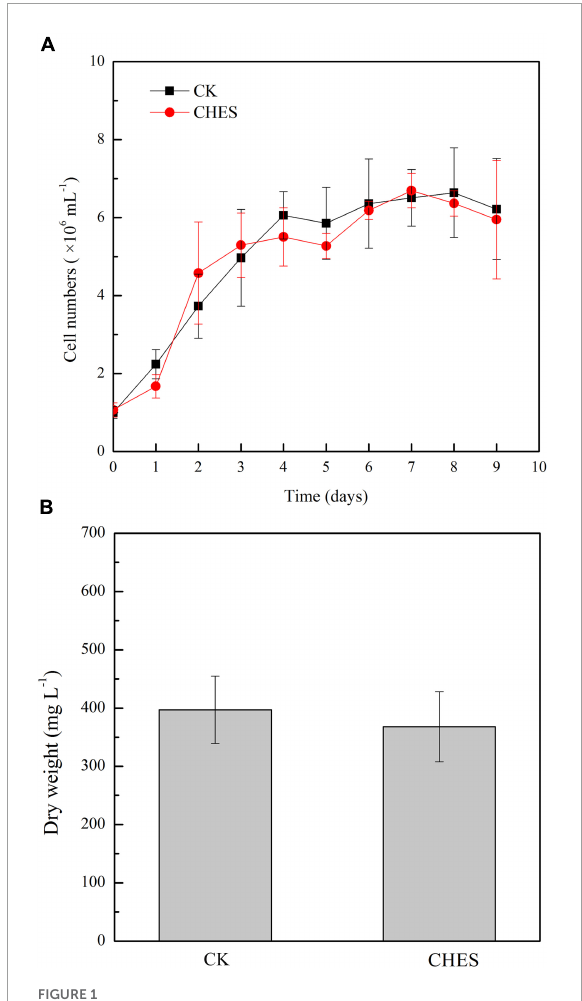
FIGURE1 Cell density and biomass was not affected by CHES in Phaeodactylum tricornutum . (A) Cell numbers were counted daily under CHES and control treatment (CK). (B) Dry weight of P. tricornutum after 8 d of culture. Each bar represents three replications. Values represent mean ± SD ( n =